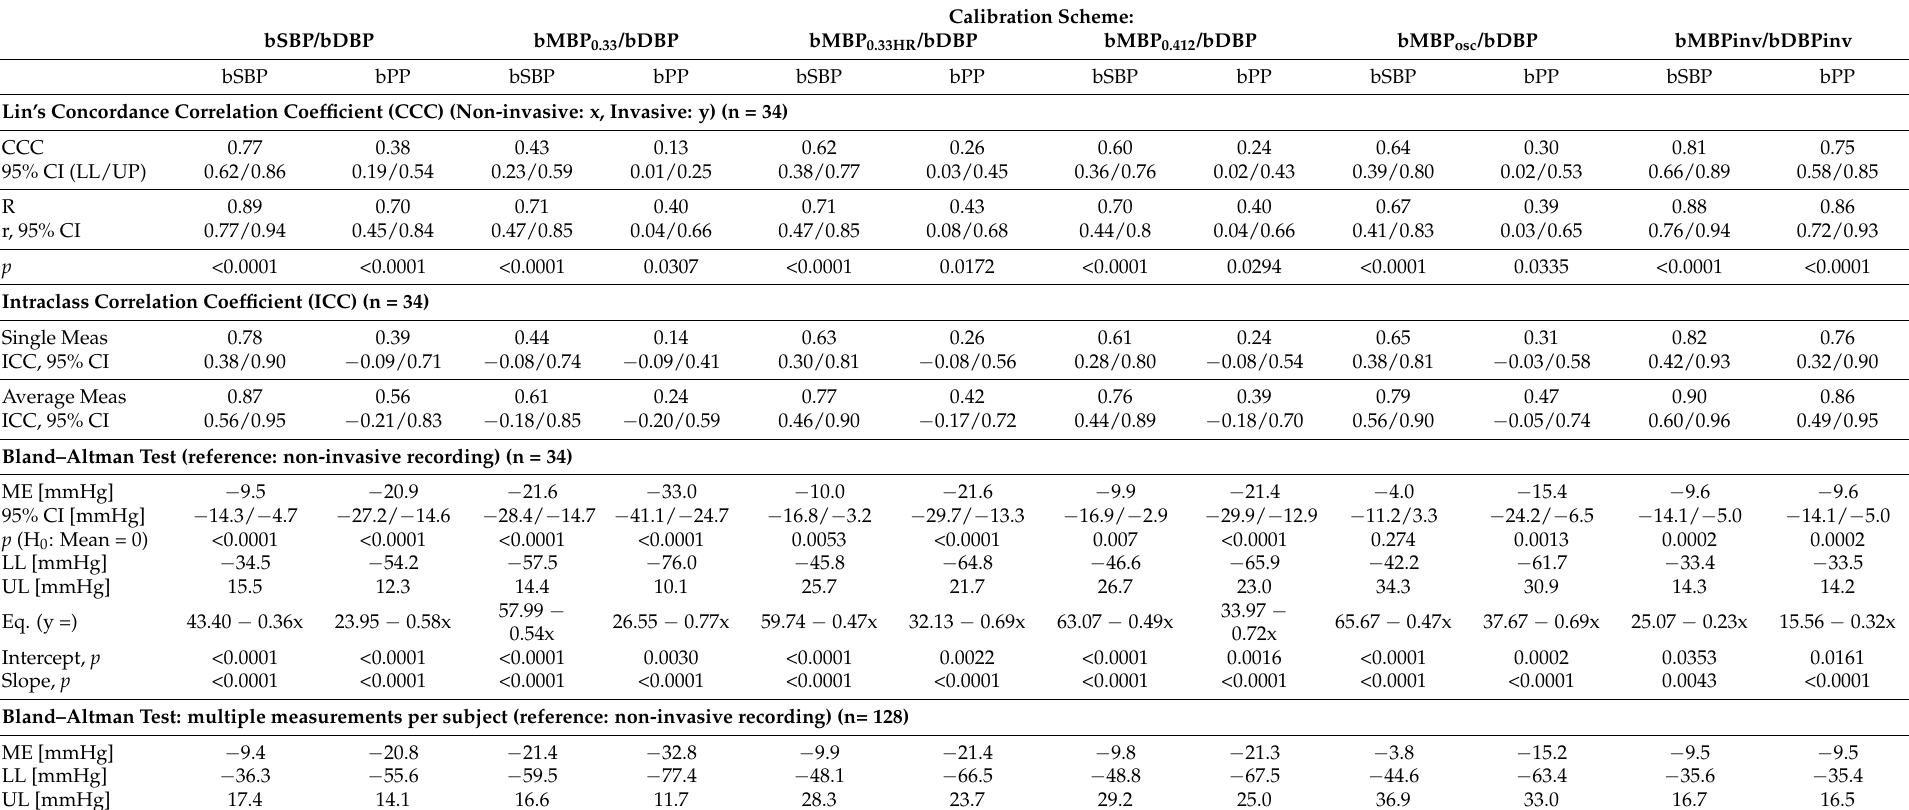
Table 5. Comparison between invasive and non-invasive (applanation tonometry) brachial blood pressure